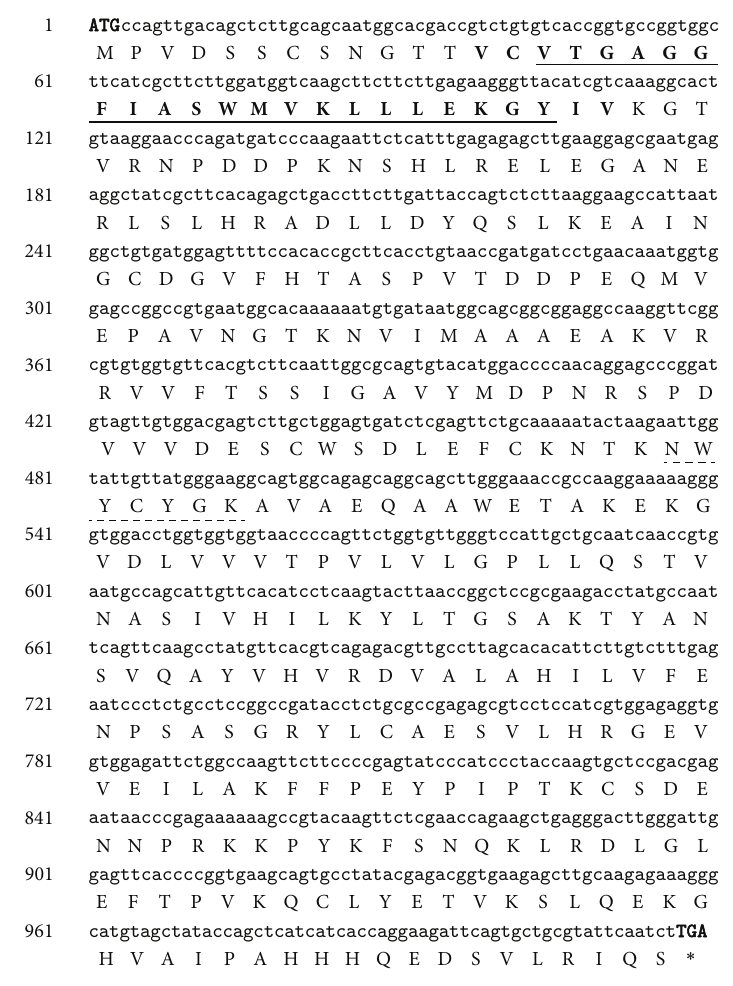
Figure 2: Full length CDS and deduced amino acid sequence of kenaf CCR1 ortholog. The start codon (ATG) and stop codon (TGA) are in uppercase. Putative NAD(P) binding domain and catalytic domain are underlined in solid and dashed line,